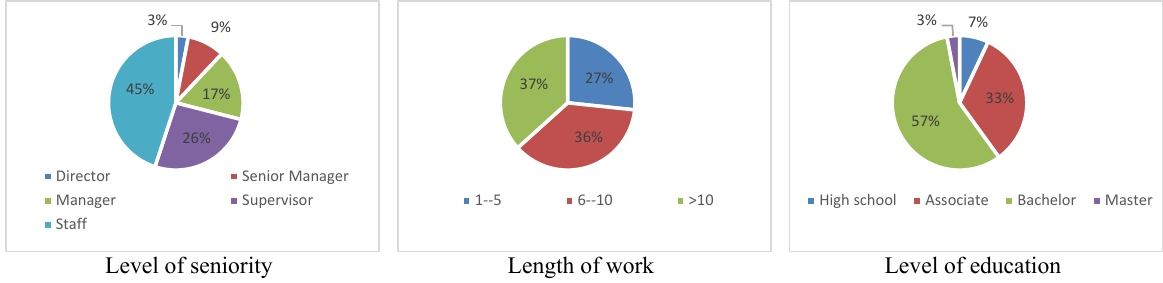
Fig. 2. Personal characteristics of the